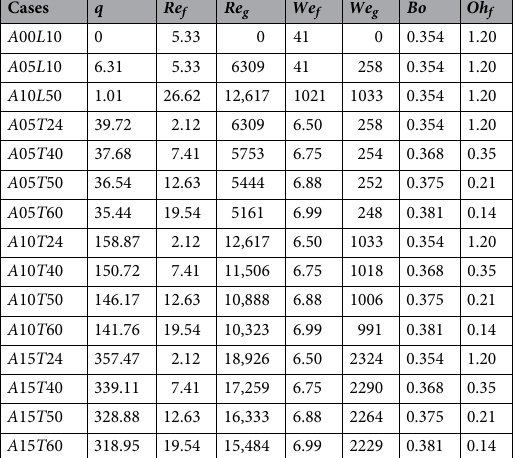
Table 2. Dimensionless groups obtained for different flow test conditions and variable physical properties.